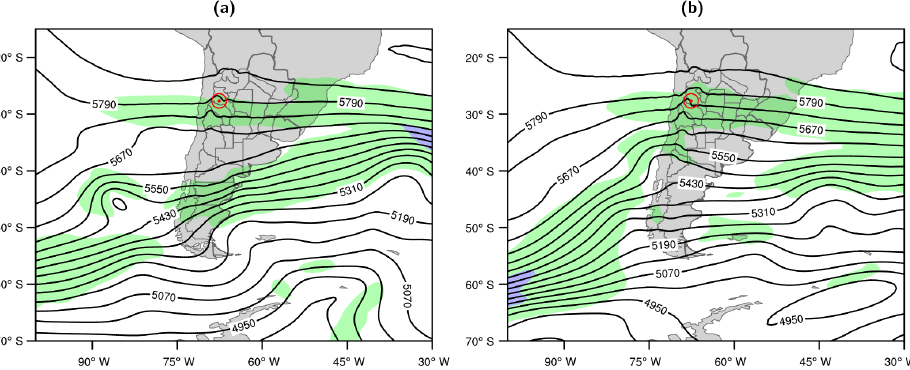
Figure 4. Meteorological situation corresponding to 12:00UTC on 12 June 2015 (a) and 12:00UTC on 13 June 2015 (b) . Solid line: the 500hPa geopotential height (gpm). Shaded green contour: wind speed > 24ms − 1 . Shaded blue contour: wind speed > 48ms − 1 . Fiambalá location is stated by a red circle. Dataset from ERA-Interim reanalysis.